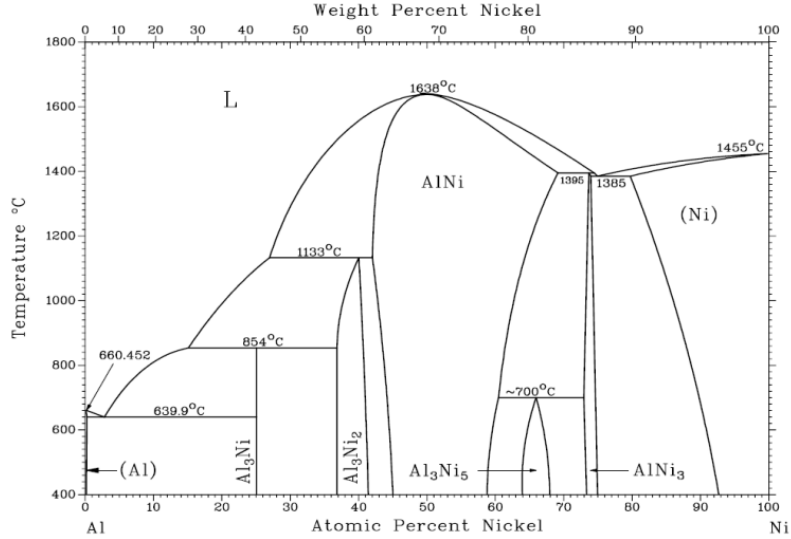
Figure 1. NiAl phase diagram.